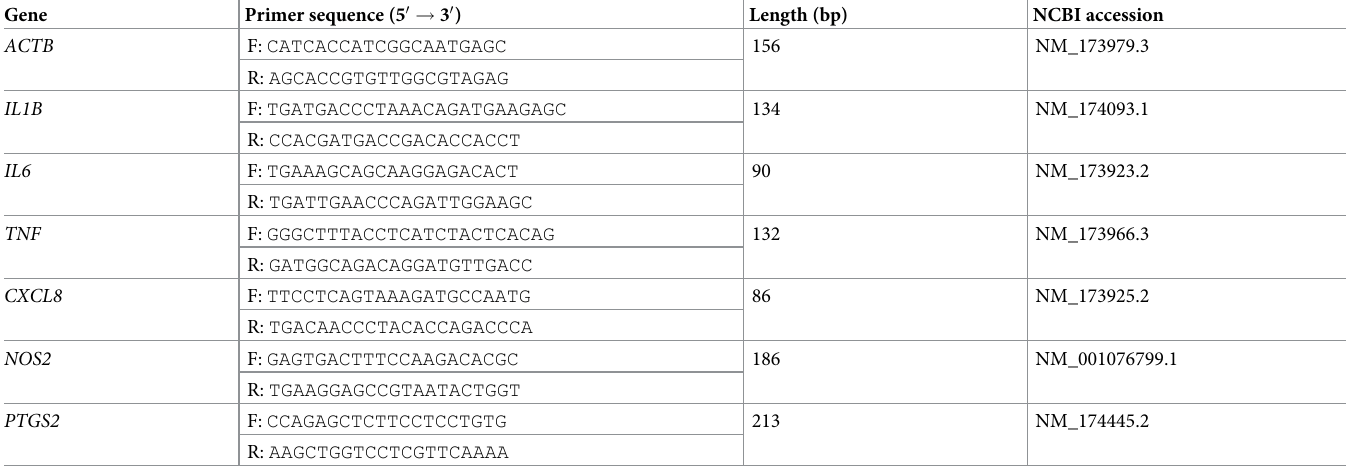
Table 1. Primer sequences used for quantitative PCR.